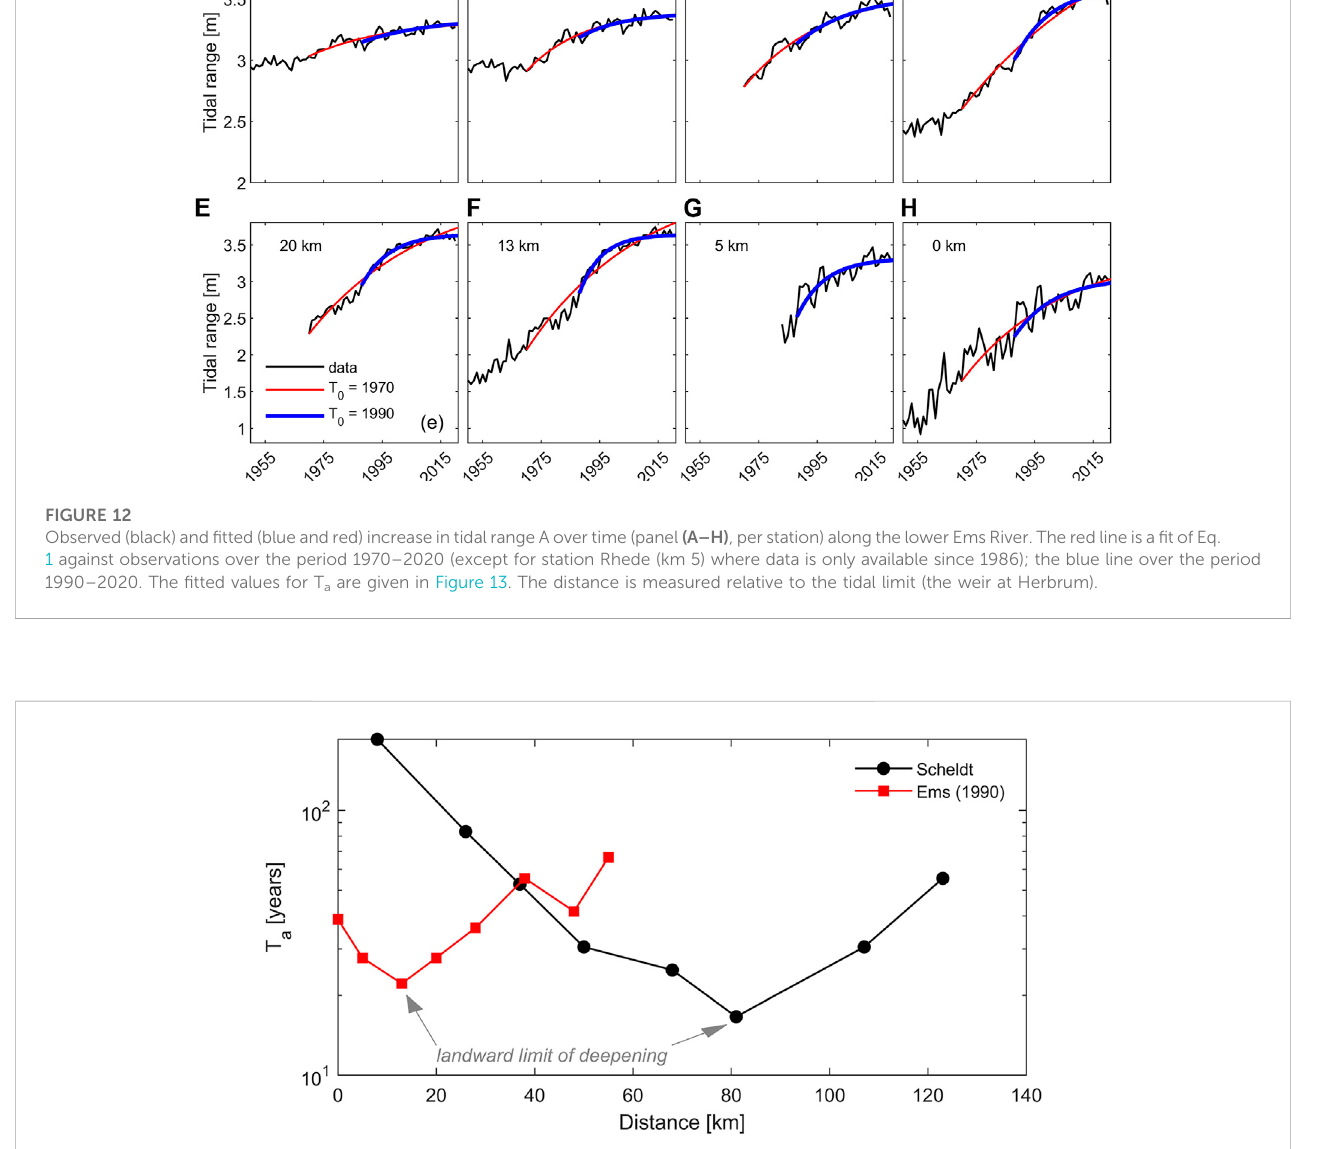
FIGURE 13 AdaptationtimescalesT a todeepeningasafunctionofdistancefromtheirupstreamtidallimit(theweiratHerbrumfortheEmsestuaryandthesluicesat Gent for the Scheldt